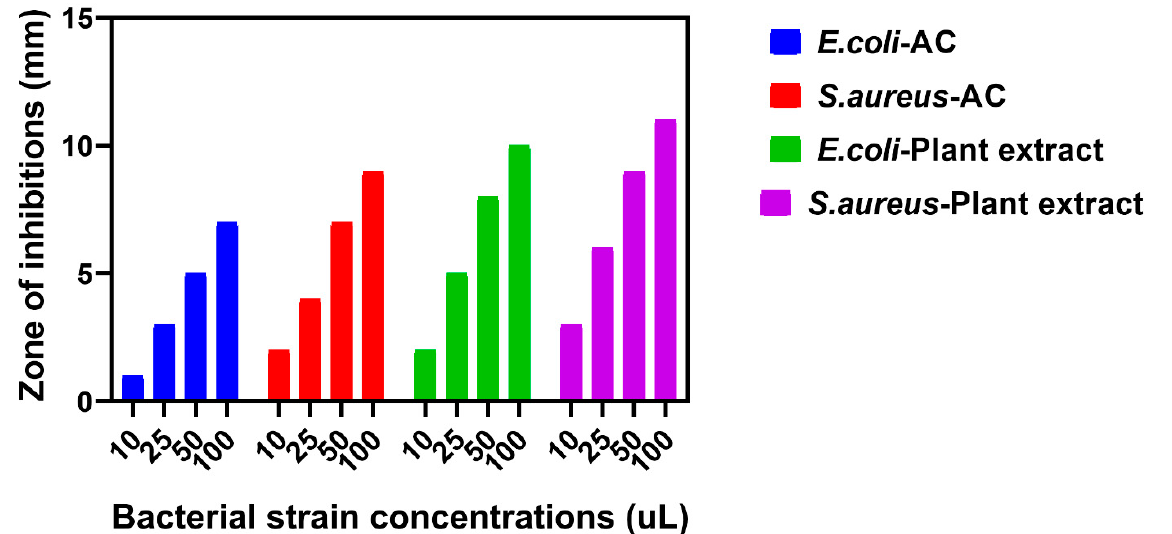
Figure 7. Zone of inhibitions of TiO 2 and AC/TiO 2 nanoparticles against various pathogens.